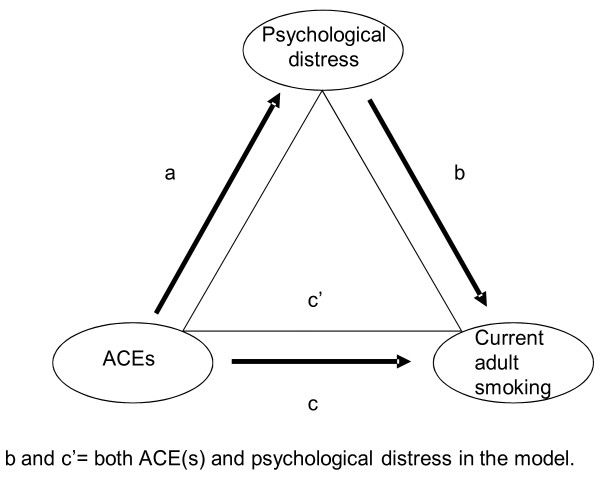
Mediation model.